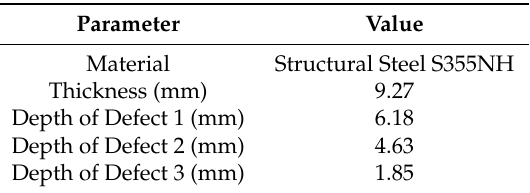
Figure 12. Image of the real pipe. Table 4. Specifications of the real